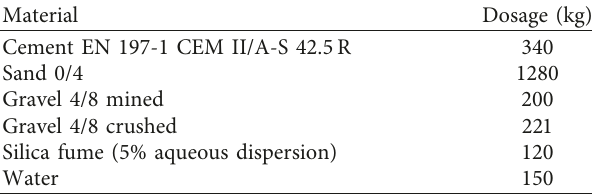
Table 1: Composition of reference concrete (REF).